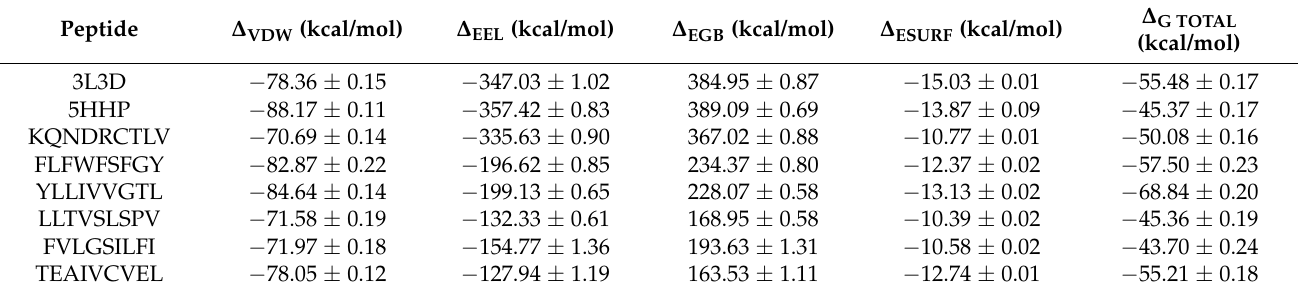
Table 4. MM/GBSA free energy calculations and individual free energy components of the selected peptide–HLA molecule complexes.